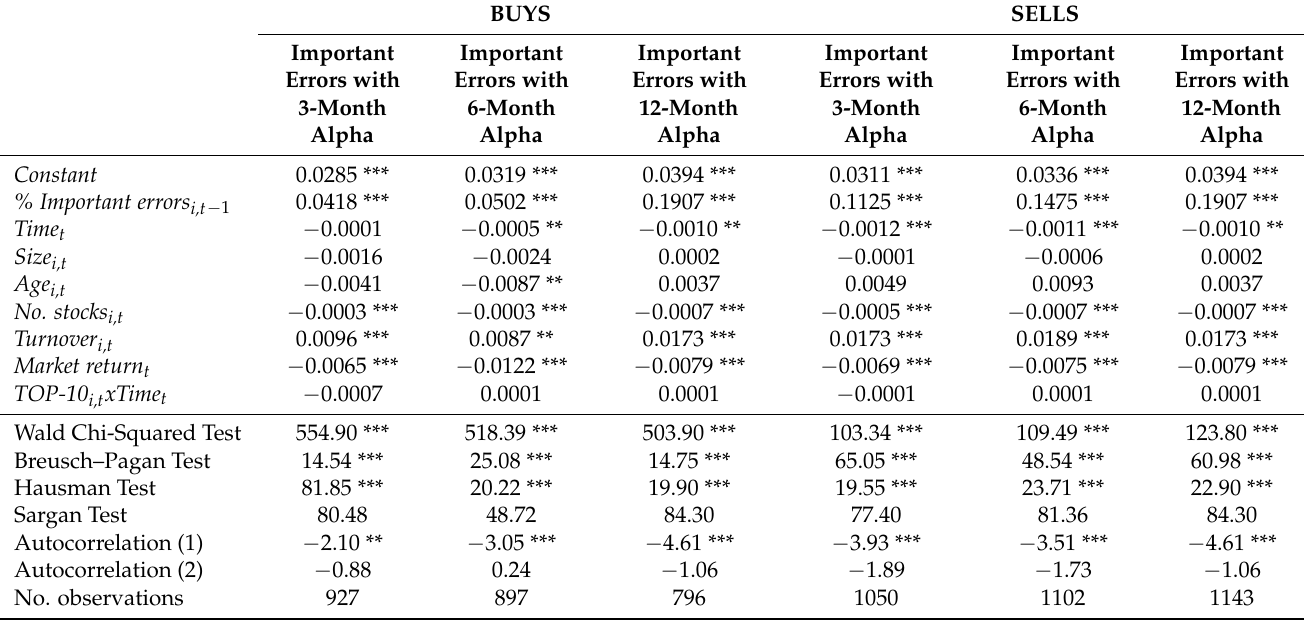
fund by the average age of all funds included in our sample in year t to avoid correlation